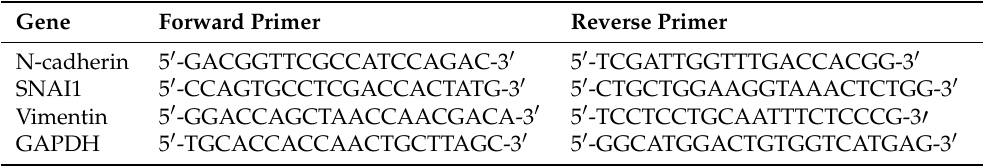
Table 1. Primer sets used for